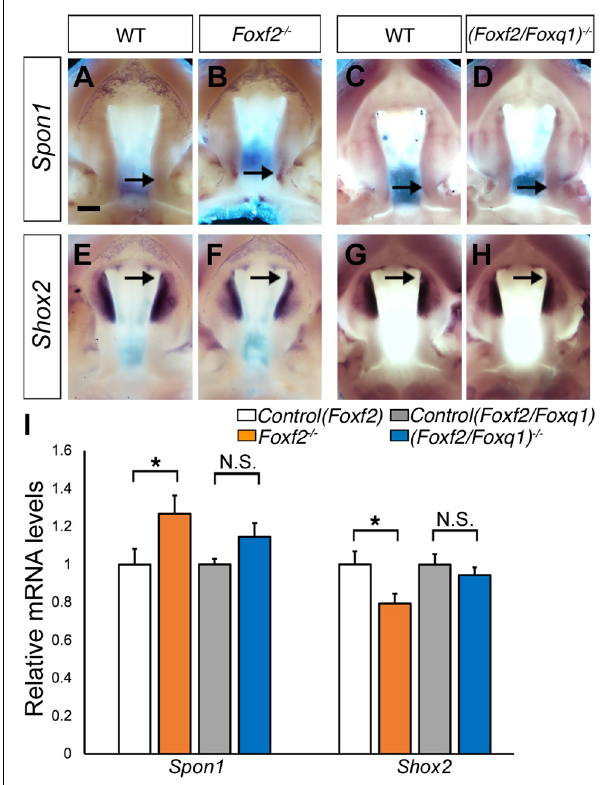
FIGURE 6 | Analysis of expression of Spon1 and Shox2 in the developing palatal shelves. (A–H) Comparison of patterns of expression of Spon1 (A–D) and Shox2 (E–H) mRNAs in E13.5 wild-type (WT) (A,C,E,G) , Foxf2 − / − (B,F) and (Foxf2/Foxq1) − / − (D,H) mutant embryos. The expression of Spon1 was increased in a specific domain in posterior palatal shelves in Foxf2 − / − embryos [arrow in (B) ]. The expression of Shox2 was decreased in the anterior palatal shelves in Foxf2 − / − embryos (arrow in F ). Scale bar, 400 µ m. (I) Real time RT-qPCR analysis of the levels of expression of Spon1 and Shox2 mRNAs in E13.5 palatal shelves in the control, Foxf2 − / − and (Foxf2/Foxq1) − / − embryos ( n = 7) * p < 0.05. N.S., not significantly different.